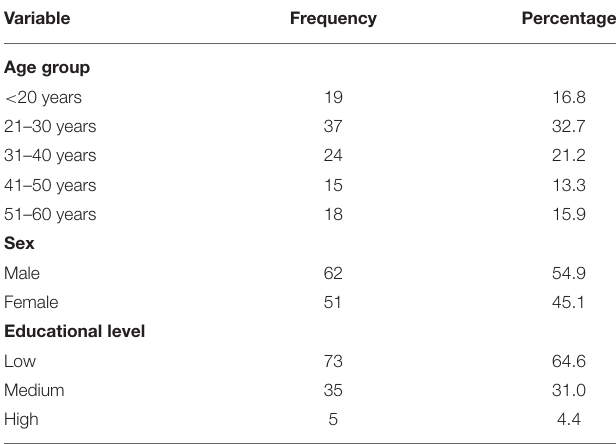
TABLE 1 | Socio-demographic descriptive characteristics of the respondents.